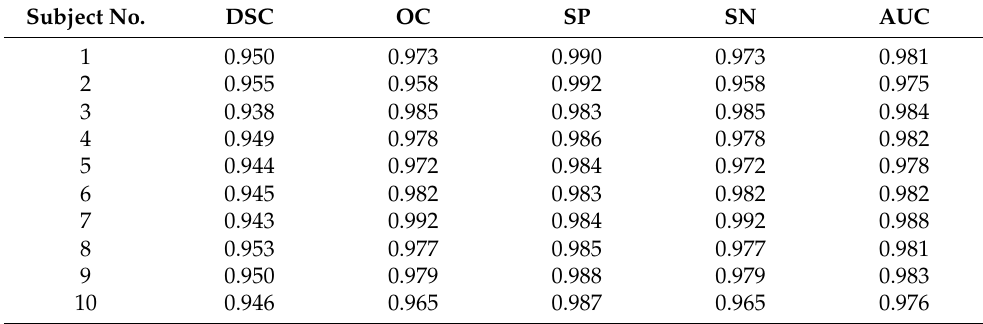
Table A3. Evaluation results for whole cerebellum segmentation, without fissures (model M3) on Hammers